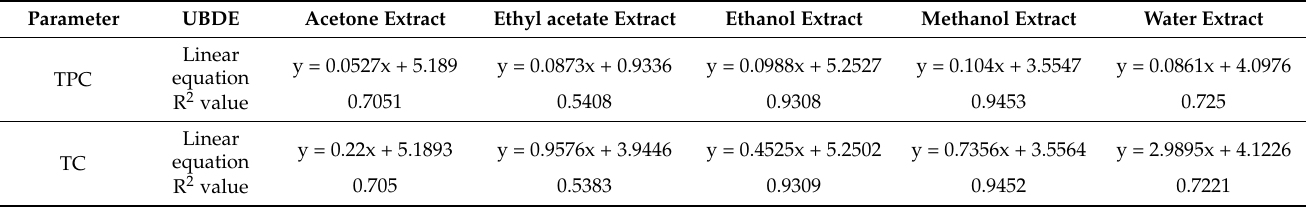
Table 4. The correlation between TCP and TC values and AA (% scavenger DPPH) for each